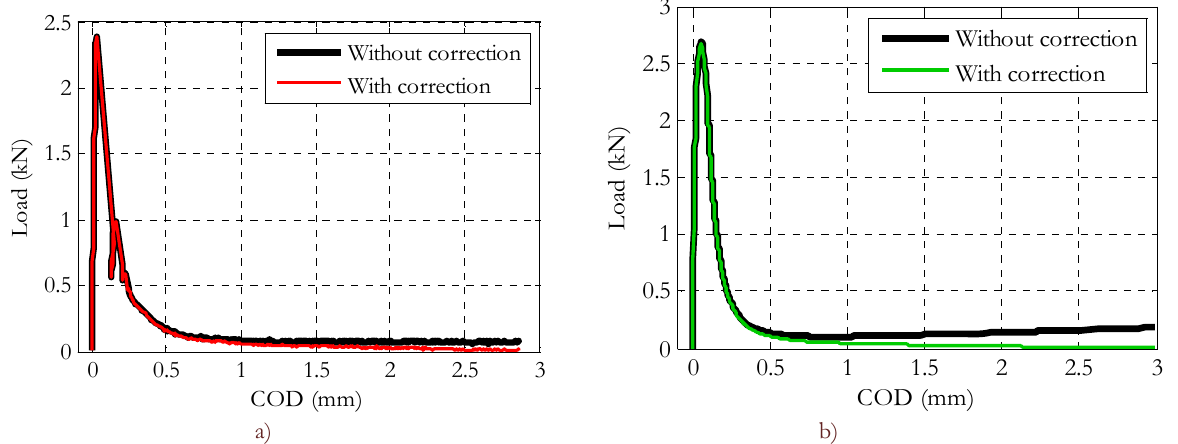
Figure 12: Original and corrected fracture energy curves for specimen 1: a) experimental and b) numerical results.